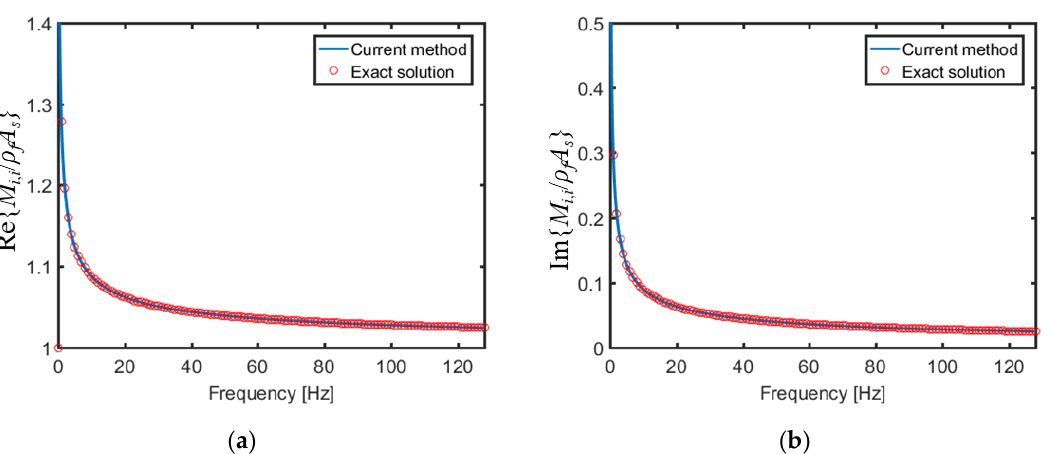
Figure 4. Comparison between exact solutions and calculated added masses of a single cylinder using Lin’s method: ( a ) real part and ( b ) imaginary part.